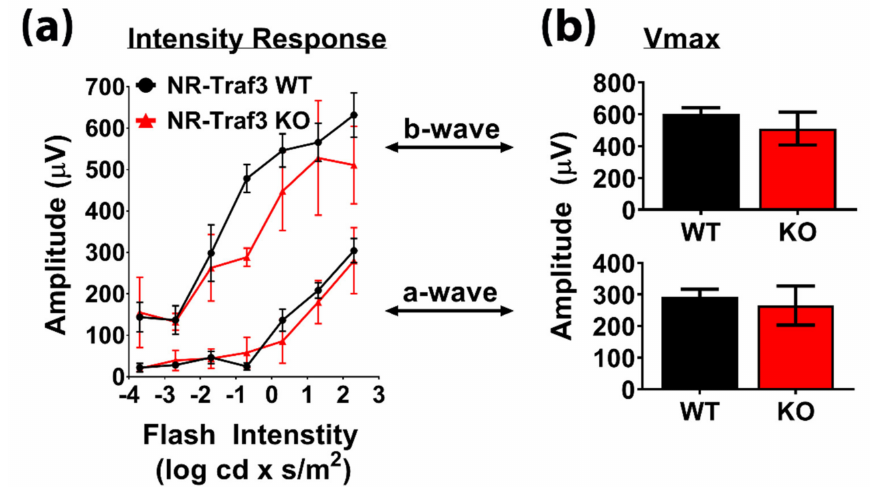
Figure 5. NR- Traf3 KO mice exhibit normal basal retinal function. Scotopic electroretinography (ERG) data represent electrical response curves for ( a ) increasing flash intensity exposures. Response curves were used to determine ( b ) maximum amplitudes for rod photoreceptor-derived a-wave and b-wave responses. NR- Traf3 KO resulted in decreased b-wave amplitude at − 1 log cd × s/m 2 ; however, there was no physiological difference in Vmax for either a- or b-waves between NR- Traf3 WTs and Kos. ( n = 3–7; Student’s t -test, not